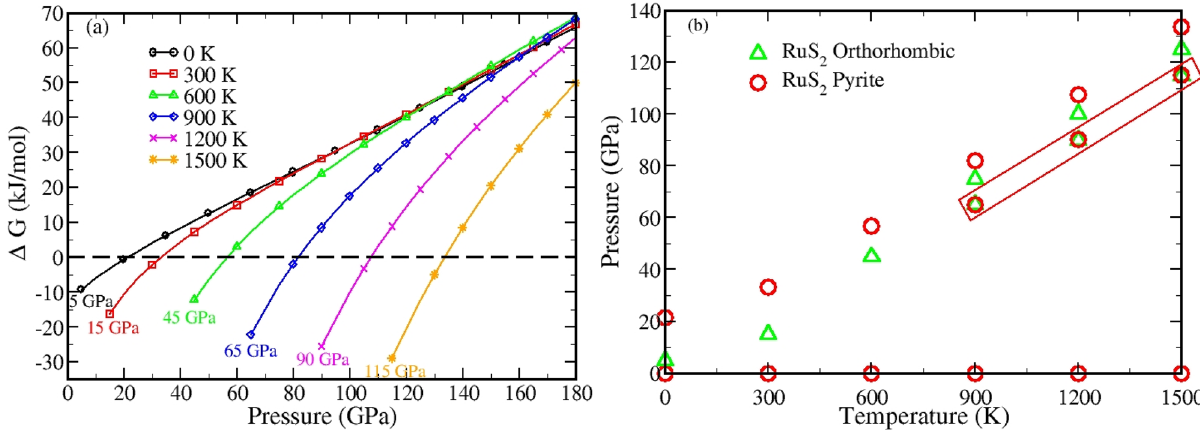
Figure 2. (a) Evolution of Gibbs free energy (∆G) with temperature and pressure for pyrite and orthorhombic phase of RuS 2 (b) Phase stability in RuS 2 as a function of temperature and pressure. The boxed region highlights the co-existence of both